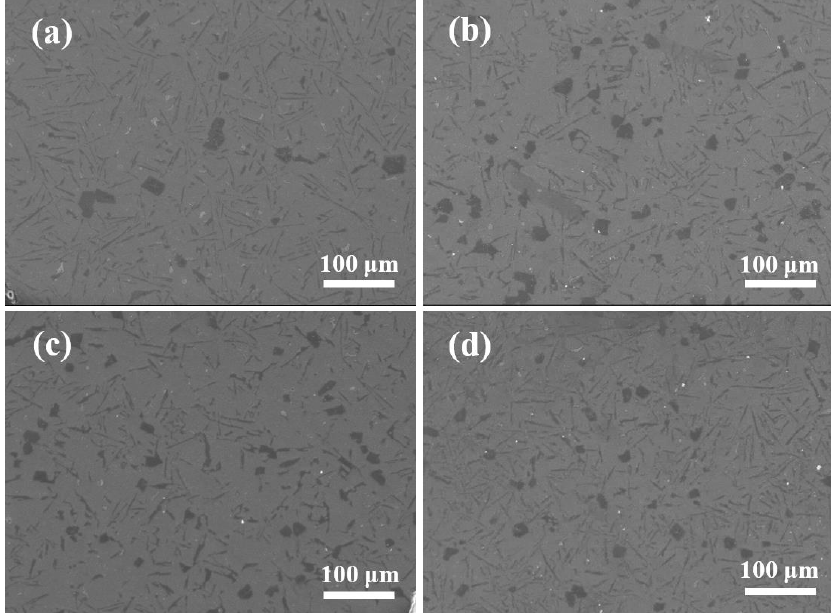
Figure 4. Microstructure diagram of Al-13Si-1Cu alloy with different addition amounts of Al-2Ti- 0.5B-0.5C master alloy: ( a ) A1 alloy, ( b ) A2 alloy, ( c ) A3 alloy, ( d ) A4 alloy.